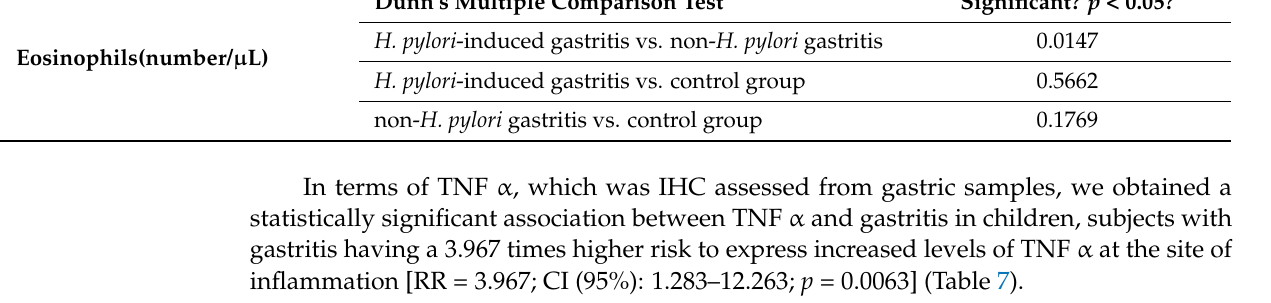
Table 7. The association of TNF α and gastritis in